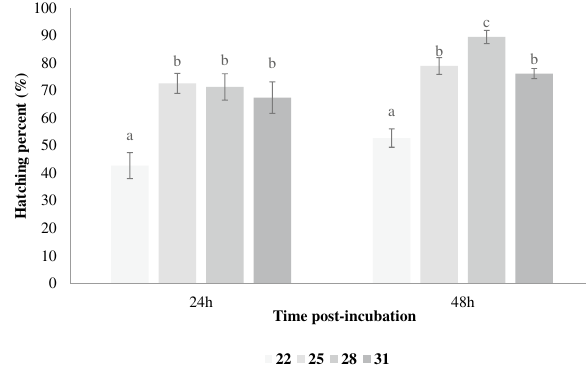
Figure 2. Effect of temperature on hatching percentage of Artemia cysts incubated on tryptic soy agar for 24 h and 48 h. Values are presented as means ± S.D. (n = 10). The same letters indicate statistically insignificant differences ( p > 0.05).